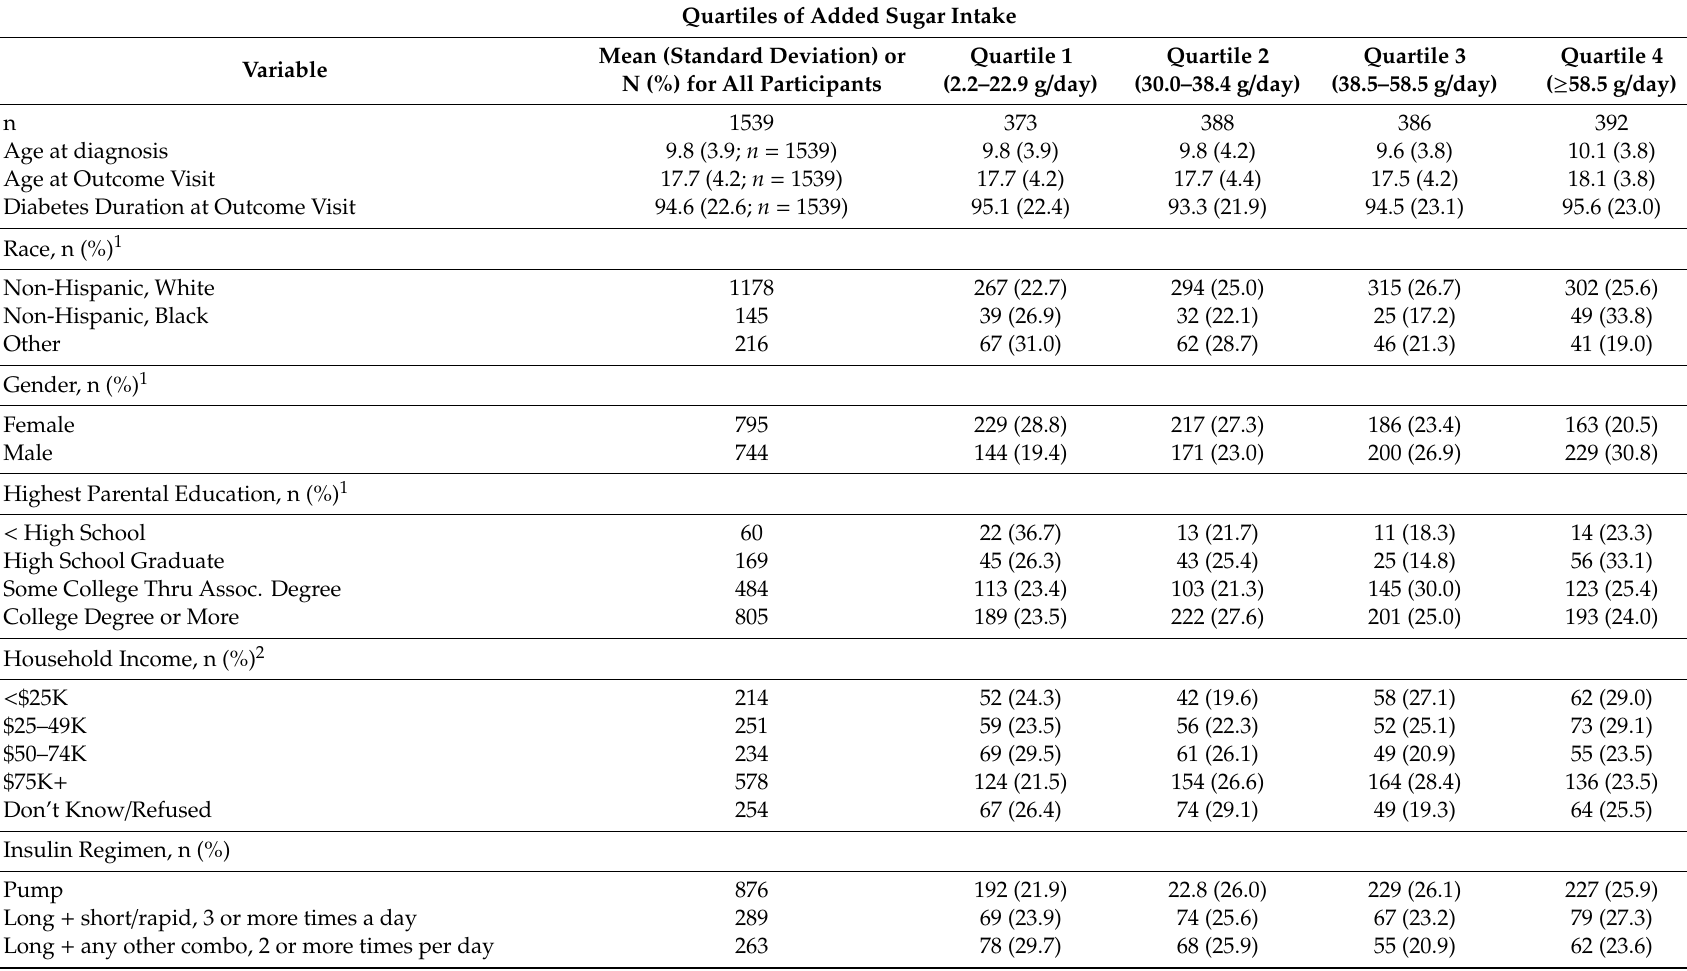
Table 1. Demographic and clinical characteristics of 1539 participants with type 1 diabetes by quartiles of added sugar: The SEARCH for Diabetes in Youth Study at the Cohort